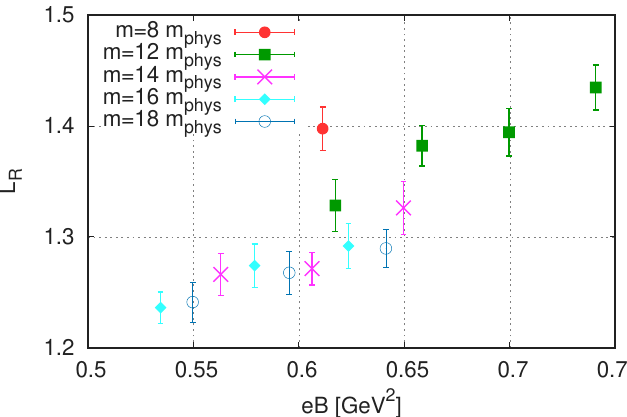
Figure 7 . The Polyakov loop ratio (3.5) around the point where inverse magnetic catalysis turns into magnetic